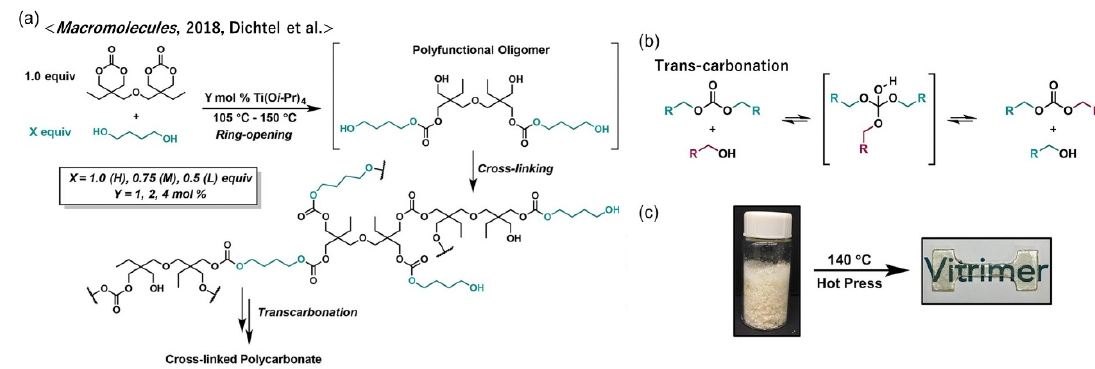
Figure 11. ( a ) Molecular design of vitrimer polycarbonates according to ref. [54]. The scheme of trans-carbonation is shown in ( b ). The visual representation of recyclability is shown in ( c ). Adapted with permission from ref. [54]. Copyright (2018) American Chemical